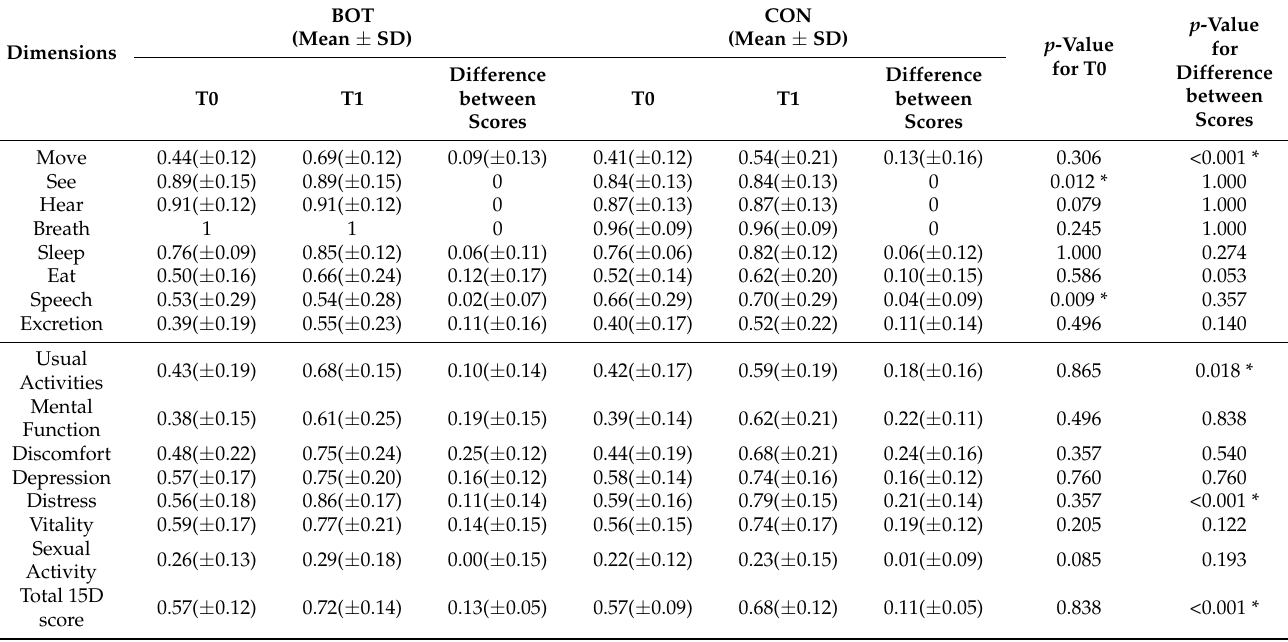
Table 3. Baseline and post-treatment changes in QoL for post-stroke patients.